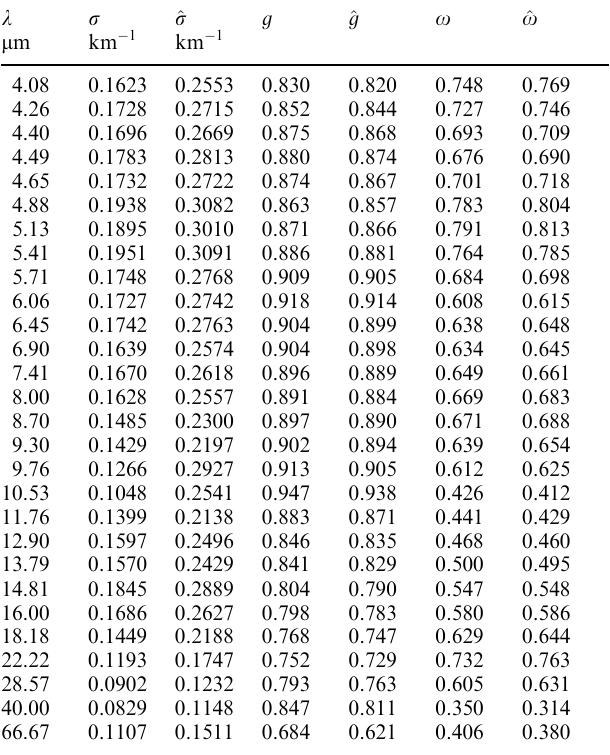
Table 8. Optical parameters of cirrus and contrail cloud models in the terrestrial region. Symbols without a hat denote cirrus parameters, symbols with a hat denote contrail parameters